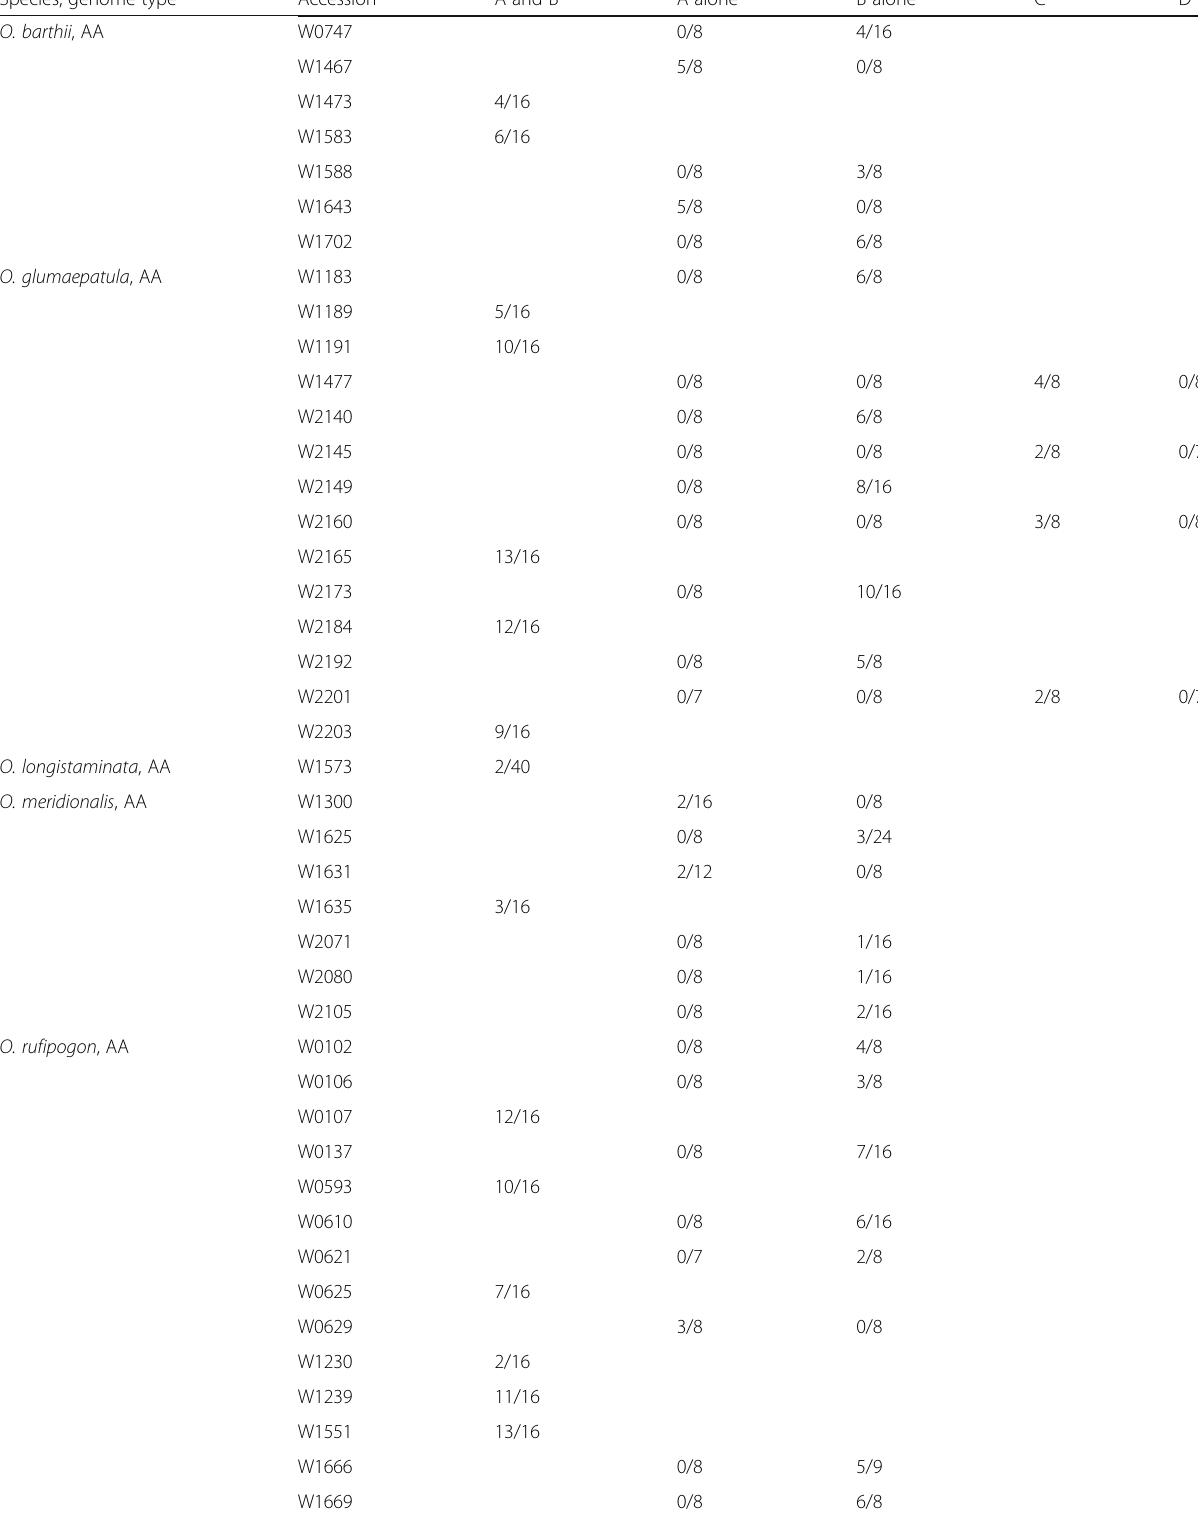
Table 2 Regeneration from immature embryos of wild Oryza accessions on 4 medium combinations (A – D) Species, genome type Accession A and B A alone B alone